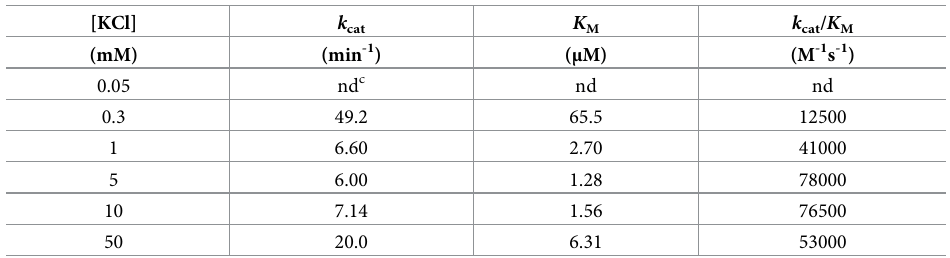
Table 1. Reactivity of HDAC3:NCOR2 and [KCl] dependency a,b . [KCl] k cat K